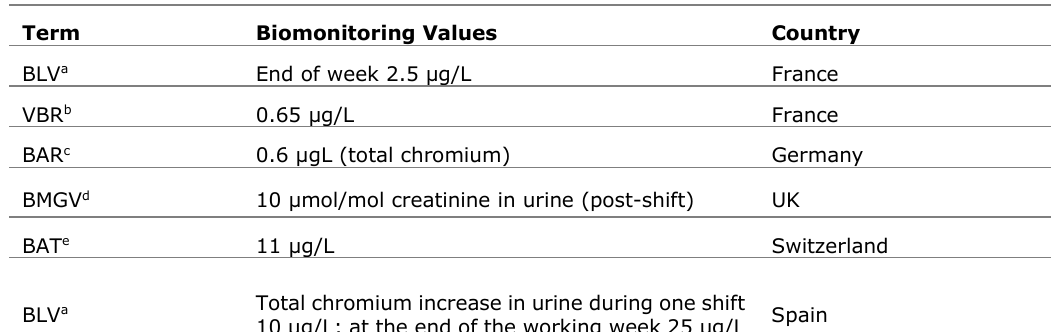
Table 1. Hexavalent chromium biomonitoring values according to country (adapted from Hartwig et al., 2017) Term Biomonitoring Values